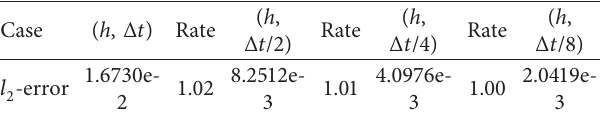
Table 1: Convergence test results of the fully implicit method for time step.